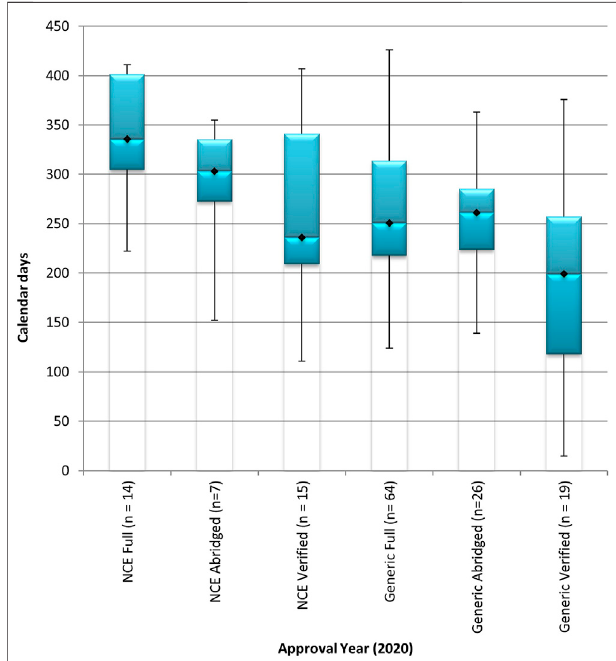
FIGURE 3 | Median overall approval times for new chemical entities and generics, in the backlog review stream, processed through the full review model, the abridged review model, and the veri fi cation model in 2020. BL, backlog; NCE, new chemical entity. Data are shown for NCEs and generics in the backlog process stream that were approved in 2020 using the full, abridged and veri fi cation review models. (n1) (cid:1) number of